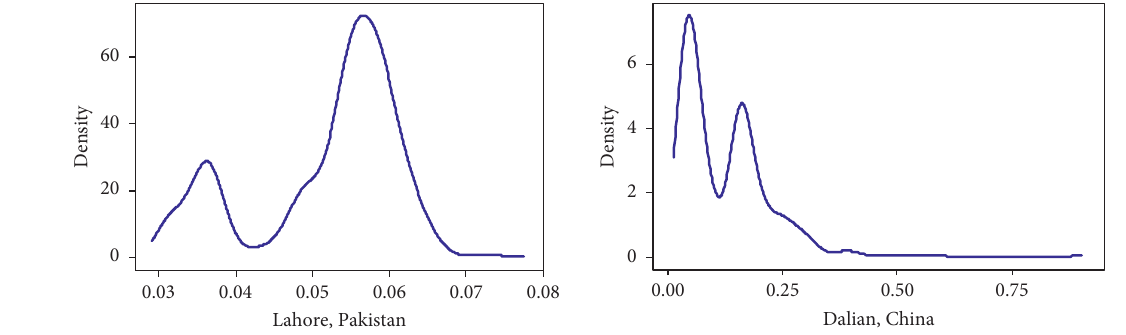
Figure 11: Distribution of travel time in Lahore and Dalian. Table 8: Explanation of sociodemographic factors in Lahore and